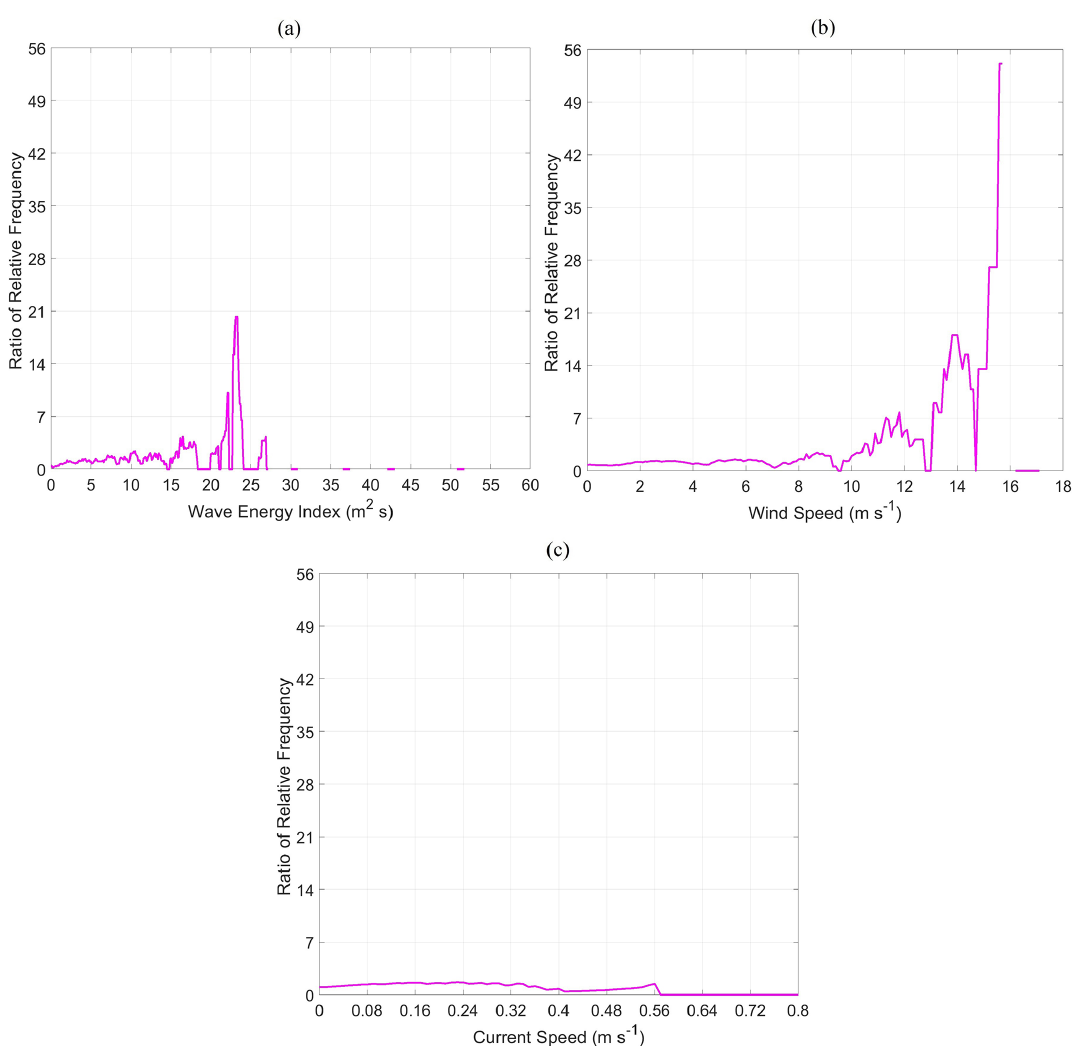
Figure A3. The ratio of the relative frequency for fracture events and all observations over the range of wave energy index (a) , wind speed (b) , and current speed (c) that surrounded the Petermann ice islands. Values close to 1 imply that fracture events are as likely to occur as the frequency of observations. Values larger than 1 indicate that fracture events are more likely to occur than the frequency of observations. Values less than 1 imply that fracture events are less likely to occur relative to the frequency of